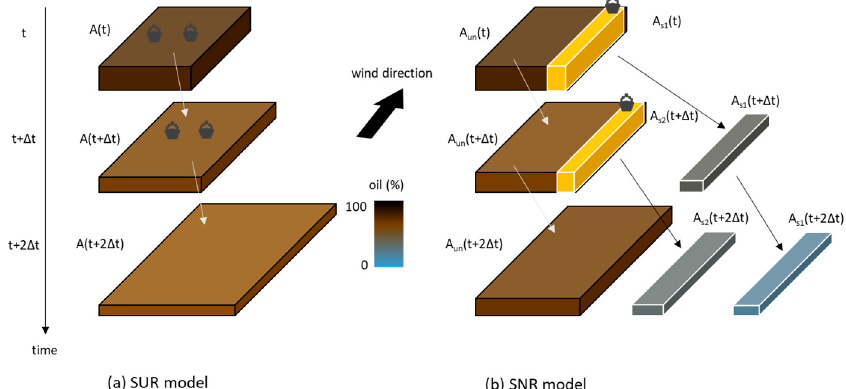
Figure 1. Schematic drawing on the correlation between oil slick behavior and the skimming zone in ( a ) the spatially uniform recovery (SUR) model and ( b ) the spatially nonuniform recovery (SNR) model. The yellow area represents a zone where skimming is in progress. Aun: area of the unskimmed zone; As: area of the skimmed zone. The legend shows the amount of oil remaining on the sea surface, which can also be thought of as the oil thickness variation.